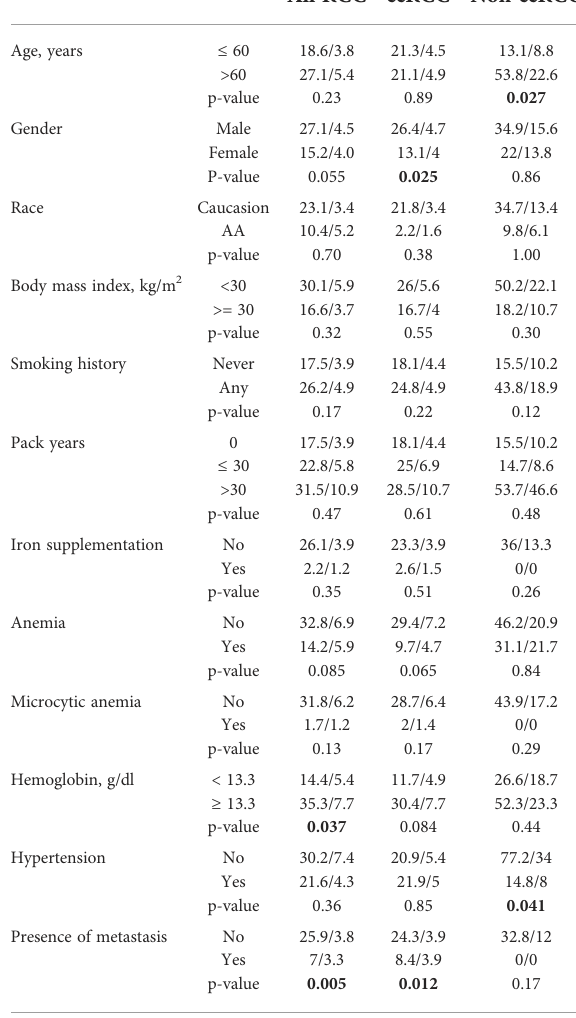
TABLE 1 Association between iron levels in primary tumor cancer cells and clinical features of patients with RCC. Tumor Iron Level (Mean H-